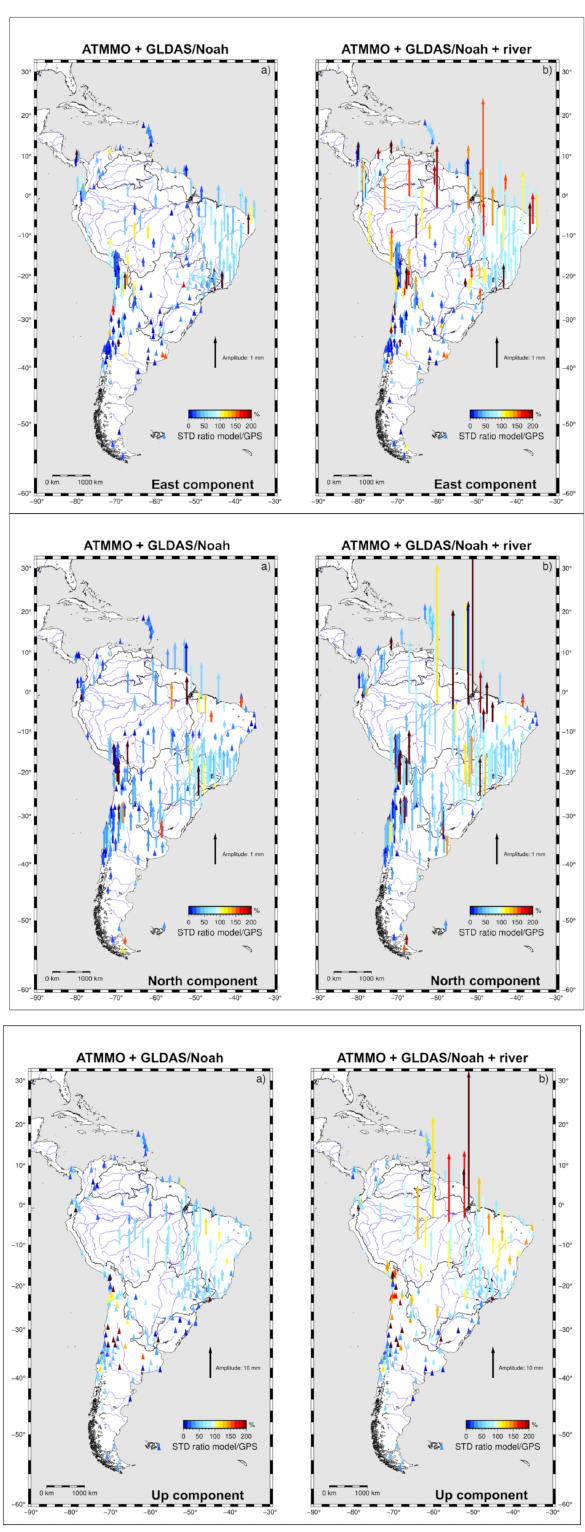
Figure 13. Map of the annual signal estimated with the M-SSA for the full loading signal:( a ) without (ATMMO + GLDAS/Noah) and ( b ) with the river contribution (ATMMO + GLDAS/Noah + river) for the East ( top ), North ( middle ), and Up ( bottom ) components, respectively. The length of the arrows corresponds to the amplitude (in mm). The color-scale represents the standard deviation ratio of the model with respect to GPS (in